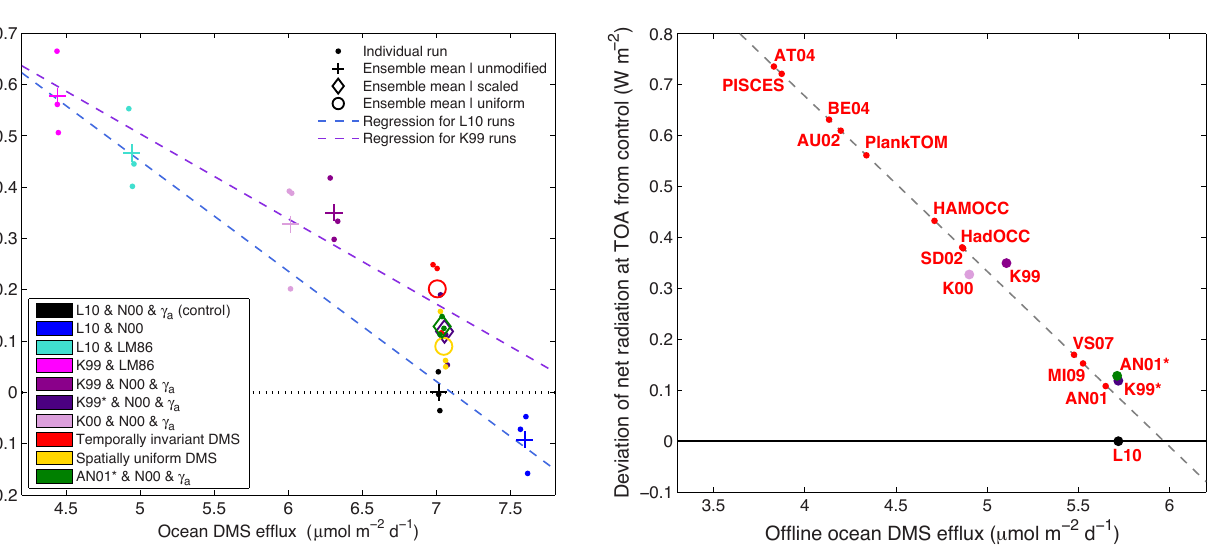
Figure 6. Estimated difference in global- and annual-mean net ra- diation at the top of the atmosphere (TOA) for the different clima- tologies considered in Tesdal et al. (2016) and the control simulation plotted against the global ocean efflux of DMS. DMS fluxes were computed offline using fields from the ERA-Interim reanalysis with N00 & γ a as the air–sea transfer scheme (large filled circles). A lin- ear regression for these runs only (grey dashed line) is used to derive estimates for other experiments (small red dots on regression line). The different climatologies considered are listed in Table 4.